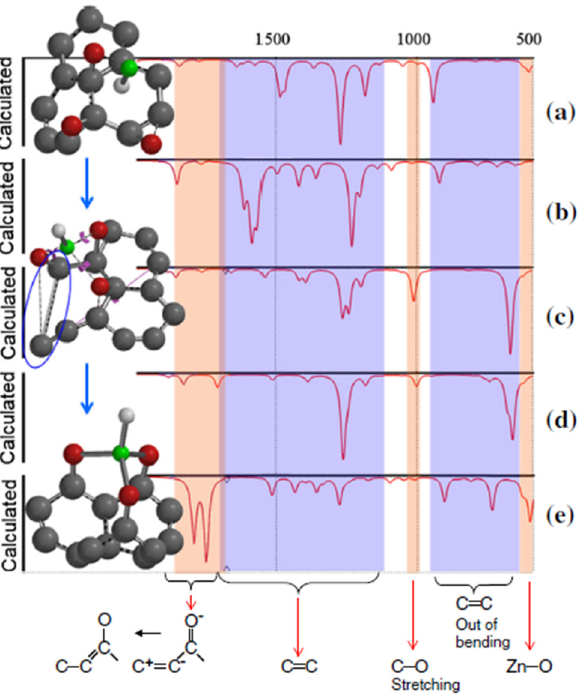
Figure 10: Infrared data when Zn – H is adsorbed onto a graphene oxide matrix [ 77 ] . ( a ) During the adsorption of Zn – H, a C = C peak corresponds to vibration out of bending, ( b ) the peaks are ascribed to the change of the carbonyl group from C = C – C = O into C + – C = C – O + , ( c ) the peak corresponds to the stretching of the C = C bond among the graphene network, ( d ) the peak indicates the complete trans - formation of the carbonyl group into C + – C = C – O + and ( e ) the peak corresponds to the formation of the Zn – O bond.